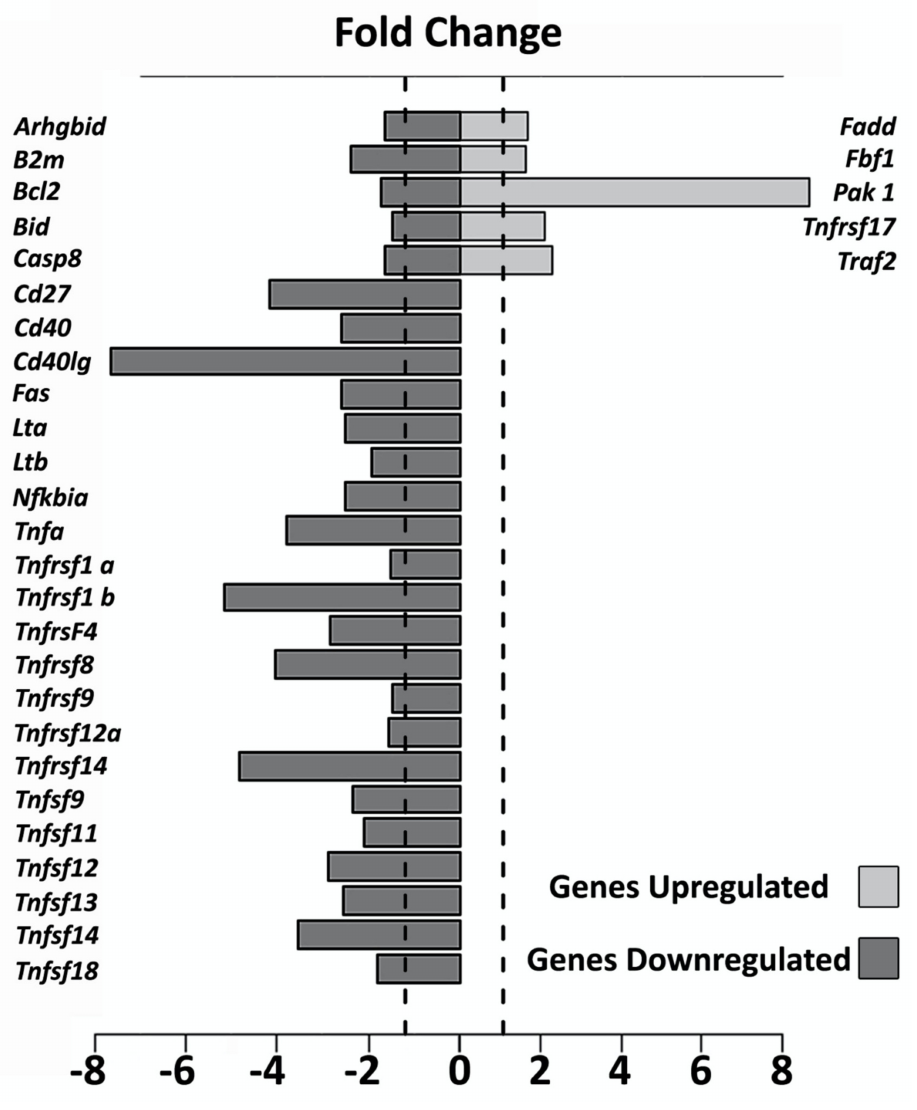
Figure 3. Fold change of the main apoptotic genes that were up and down-regulated in the cochleae of rats previously submitted (S, n = 20) or not submitted (NS, scramble, n = 20) to TNF α blockade by gene silencing before and after noise